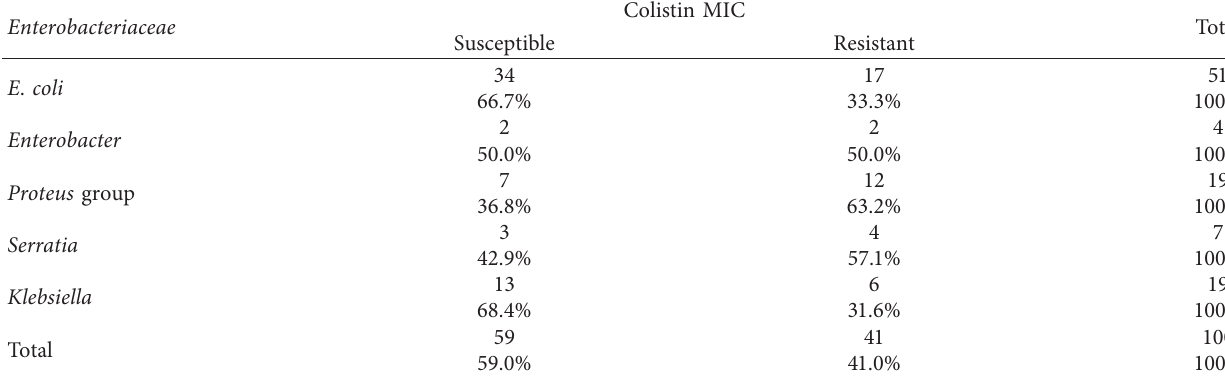
Table 5: MIC values for various Enterobacteriaceae .